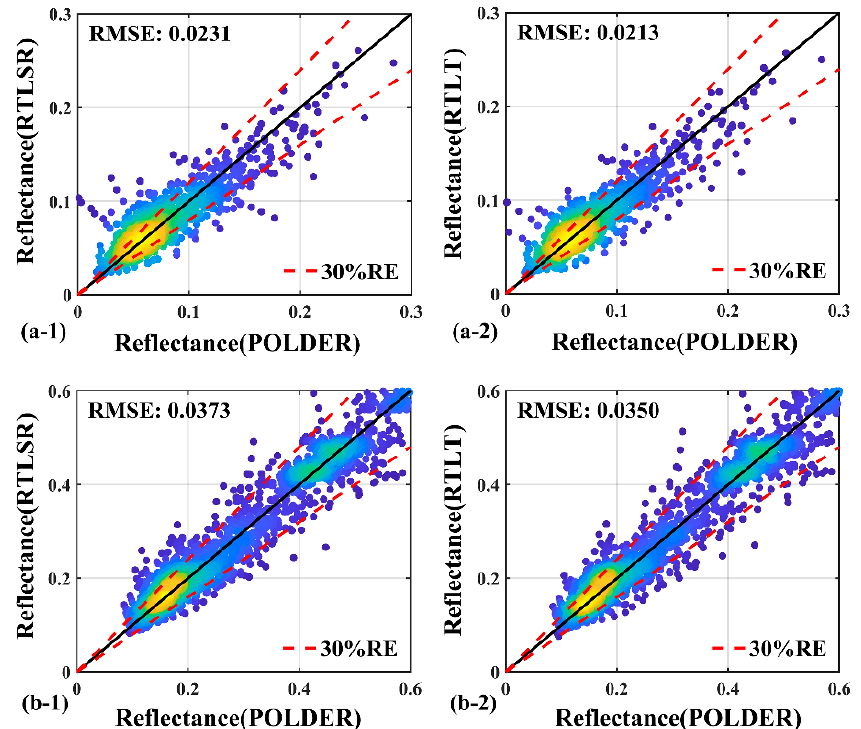
Figure 6. Comparison of the reflectance predicted by RTLSR and RTLT with POLDER observations using data with large SZA. The red dotted lines mean 30% RE. The colors correspond to point density from lowest (blue) to highest (yellow). The horizontal axes represent the reflectance from POLDER. The vertical axes represent the reflectance from RTLSR or RTLT model. ( a , b ) represent the red and NIR bands. (1) and (2) represent the RTLSR and RTLT models, respectively.